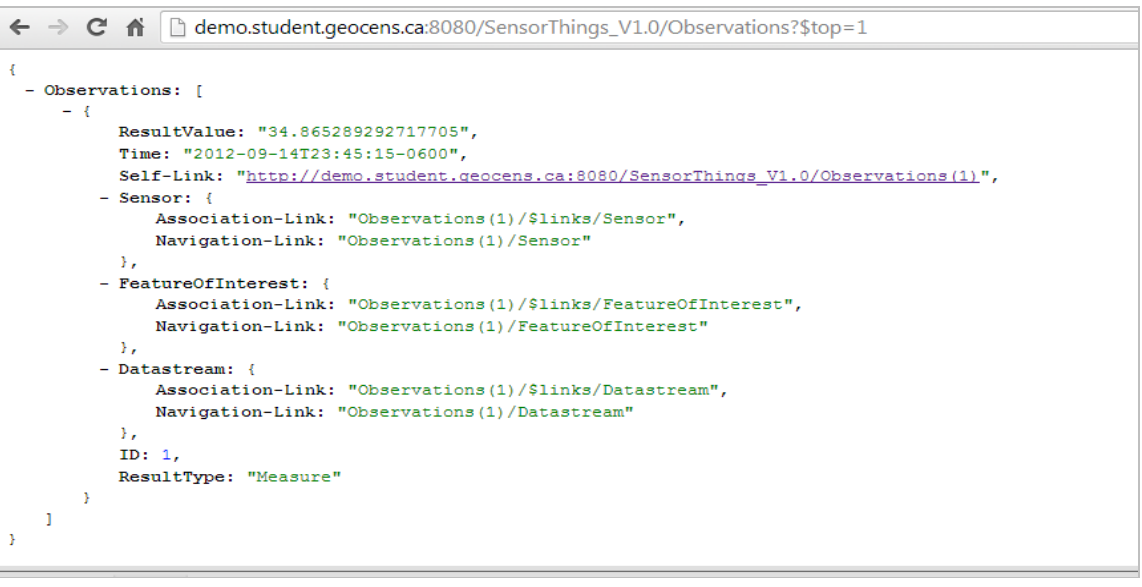
Figure A6. HTTP GET request and response to the OGC SensorThings through the